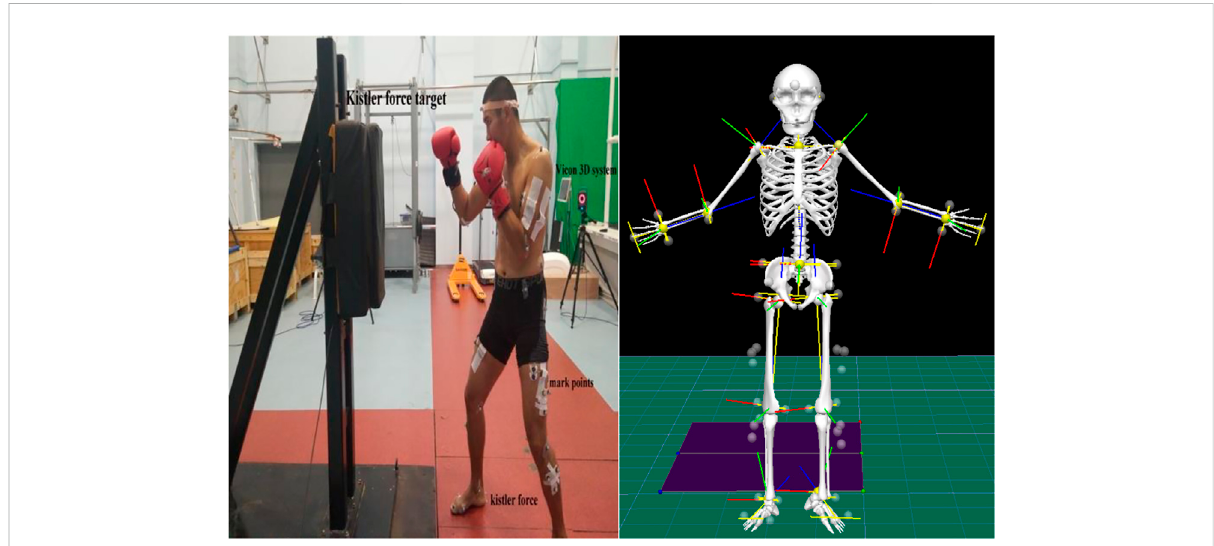
FIGURE 1 Boxer preparation posture with Kistler ’ s force target fi xed on tripod and two force gauges on both legs.